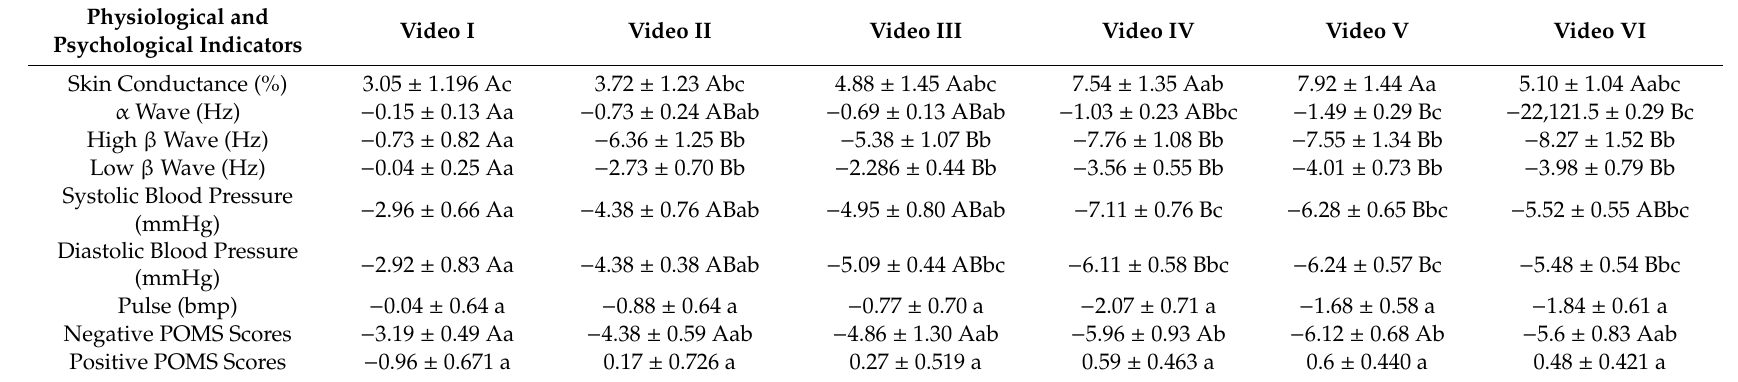
Table 2. Changes in physiological and psychological indicators of each bamboo horizontal 360 ◦ video.